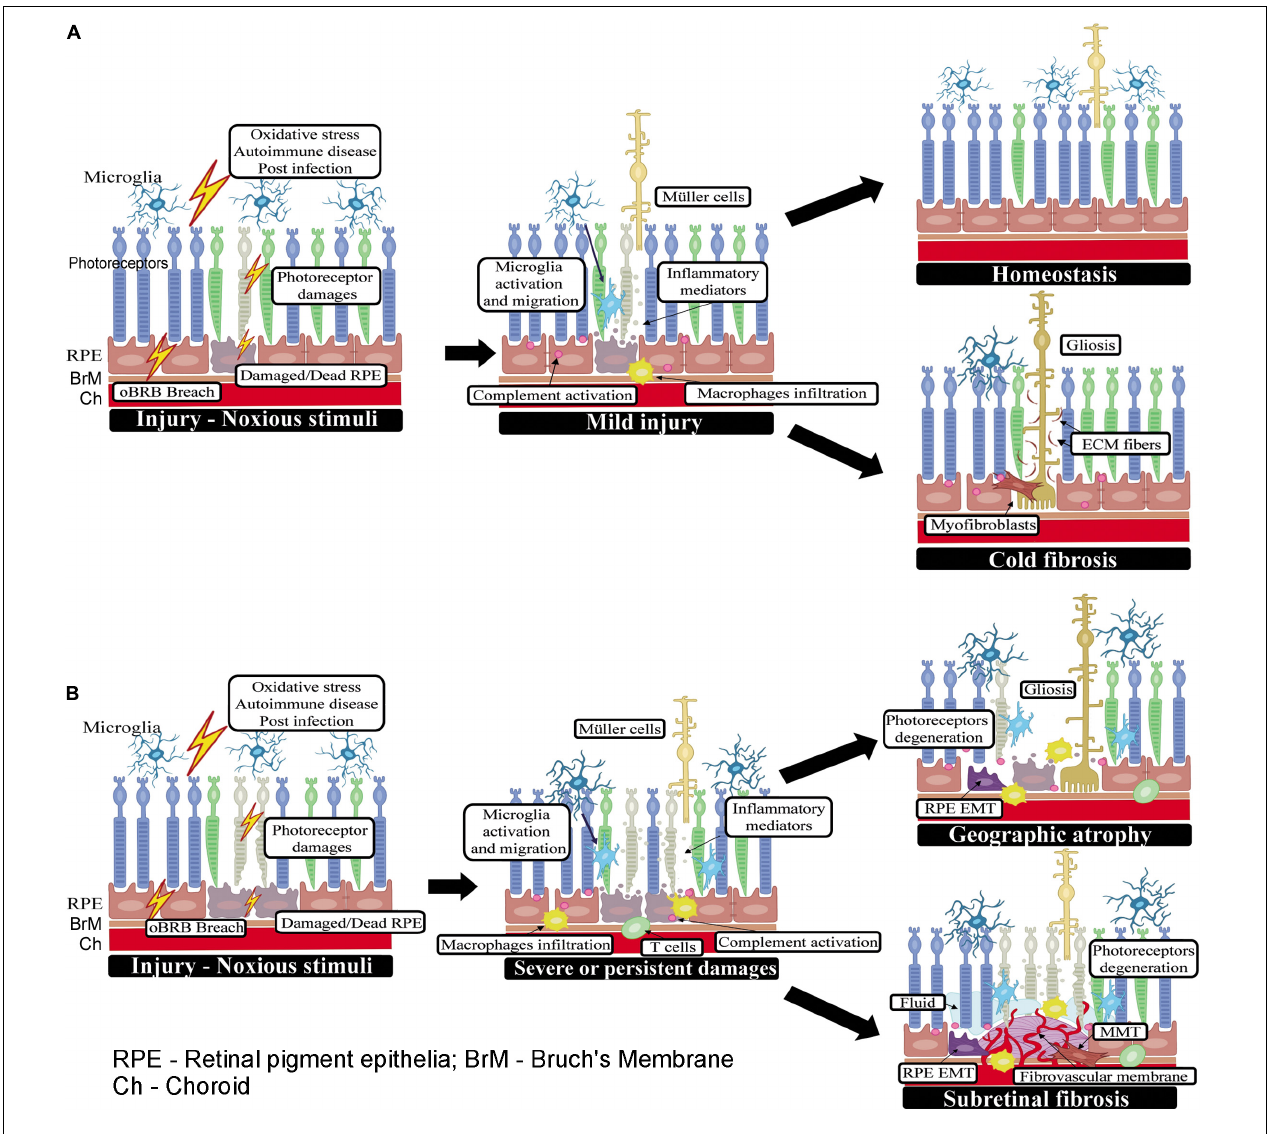
FIGURE 1 | Wound healing in the subretinal space. (A) When the initial insult is mild or one-off, the injury can be promptly rectified by retinal innate immune system (may also be assisted by infiltrating innate immune cells) and the subretinal space returns to homeostasis. If the injury causes a significant number of photoreceptor loss, Müller cells will be activated (may also be transdifferentiated into myofibroblast). Muller cells, myofibroblasts along with ECM proteins produced by them will fill the space left by dead cells forming gliosis without ongoing inflammation (or cold fibrosis). (B) When the insult to photoreceptors or RPE cells persists or is severe, retinal immune system, circulating innate and adaptive immune cells may all participate in the healing process. If the subretinal damage does not involve the ingrowth of new blood vessels, such as in GA and RRD, the damaged photoreceptor/RPE cells may be replaced by active Müller glia (i.e., gliosis) or myofibroblasts transdifferentiated from other cells such as RPE cells or macrophages. In RRD-induced PVR, the wound healing response leads to excessive ECM deposition and the development of subretinal fibrotic membrane; whereas, in GA, the wound is filled with active Muller glia and infiltrating immune cells without excessive ECM deposition and damage area becomes atrophic. In nAMD, new blood vessels are a part of the pathology, and the healing process is accompanied by continued immune cell infiltration and excessive deposition of ECM around the diseased blood vessels and eventually, the development of fibro-vascular